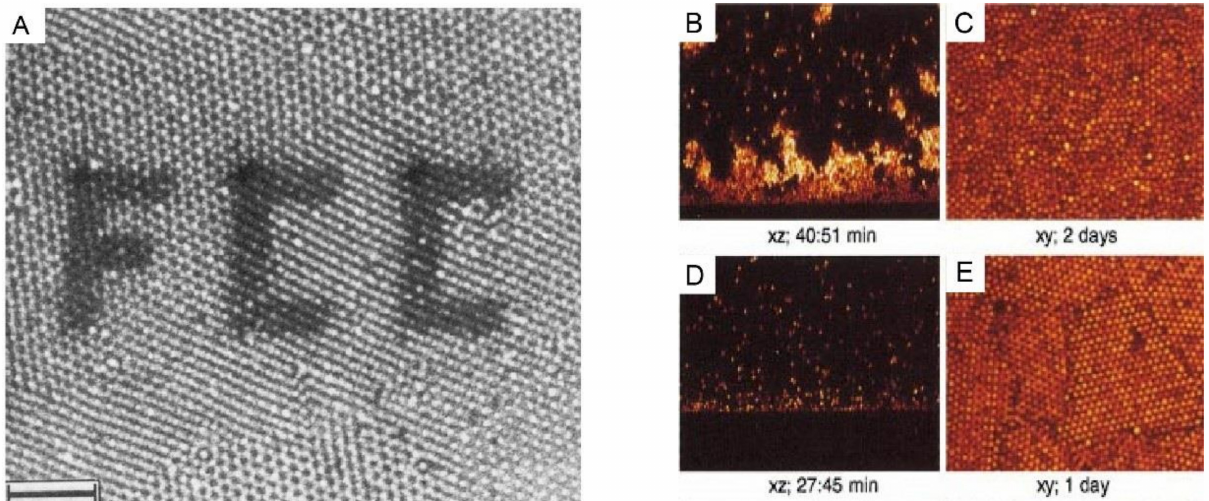
Figure 3. ( A ): A polycrystalline section of 1-octadecanol-coated silica spheres (particle radius 505 nm, initial volume fraction 20%) in chloroform inside the capillary, observed by confocal laser scanning microscope (CLSM). The photobleached pattern (FCC) was created by the high-intensity illumination with the imaging beam. Scale bar: 10 µ m. ( B – E ): CSLM images of xz scans after an hour and of xy scans after several days for the sedimentation of polymethylmethacrylate (PMMA) particles in a reactive index matching solvent of ( B , C ): initial volume fraction: 2.05%, polymer concentration: 51.72 mg/mL; and ( D , E ): initial volume fraction: 2.18%, polymer concentration: 51.18 mg/mL. The polymers were used here to tune the interaction strength between these colloidal particles. Reproduced with the permission from [34], Copyright the American Chemistry Society, 1992; and [33], Copyright the American Physical Society, 2001.